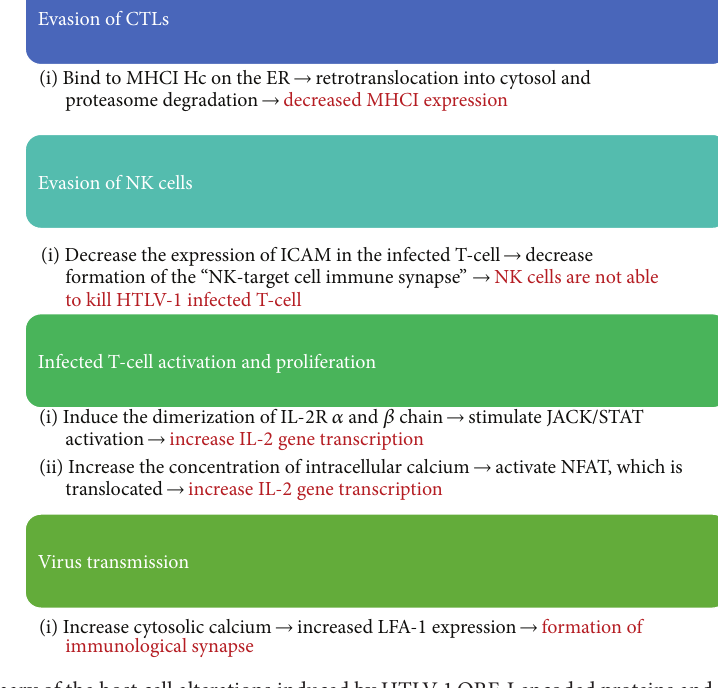
promoter, increasing the expression of this important protein to HTLV-1 infection [12, 21, 24,